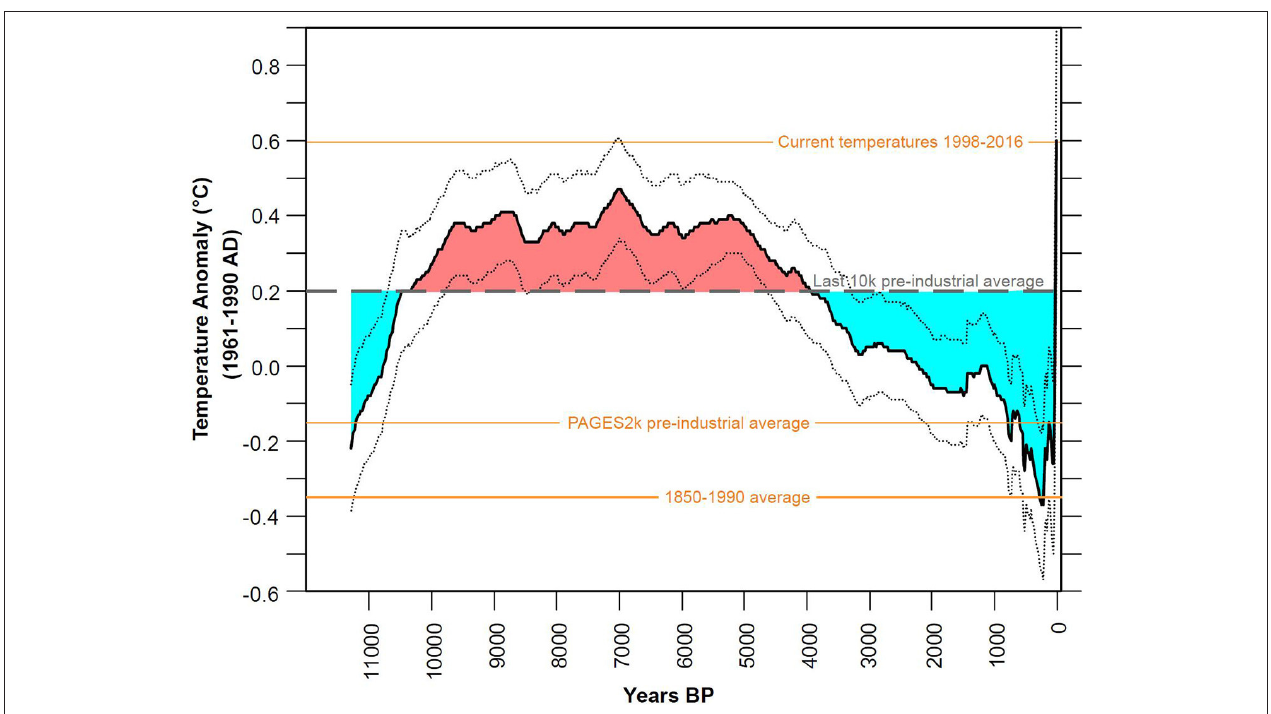
FIGURE 1 | Holocene global average sea surface temperature (SST) reconstruction after Marcott et al. (2013). Dotted lines mark 1 σ uncertainty. Gray dashed line represents approximate average SST of past 10,000 years. Other illustrated averages were taken from Figure 2 and refer to global combined land and sea temperatures, hence the greater